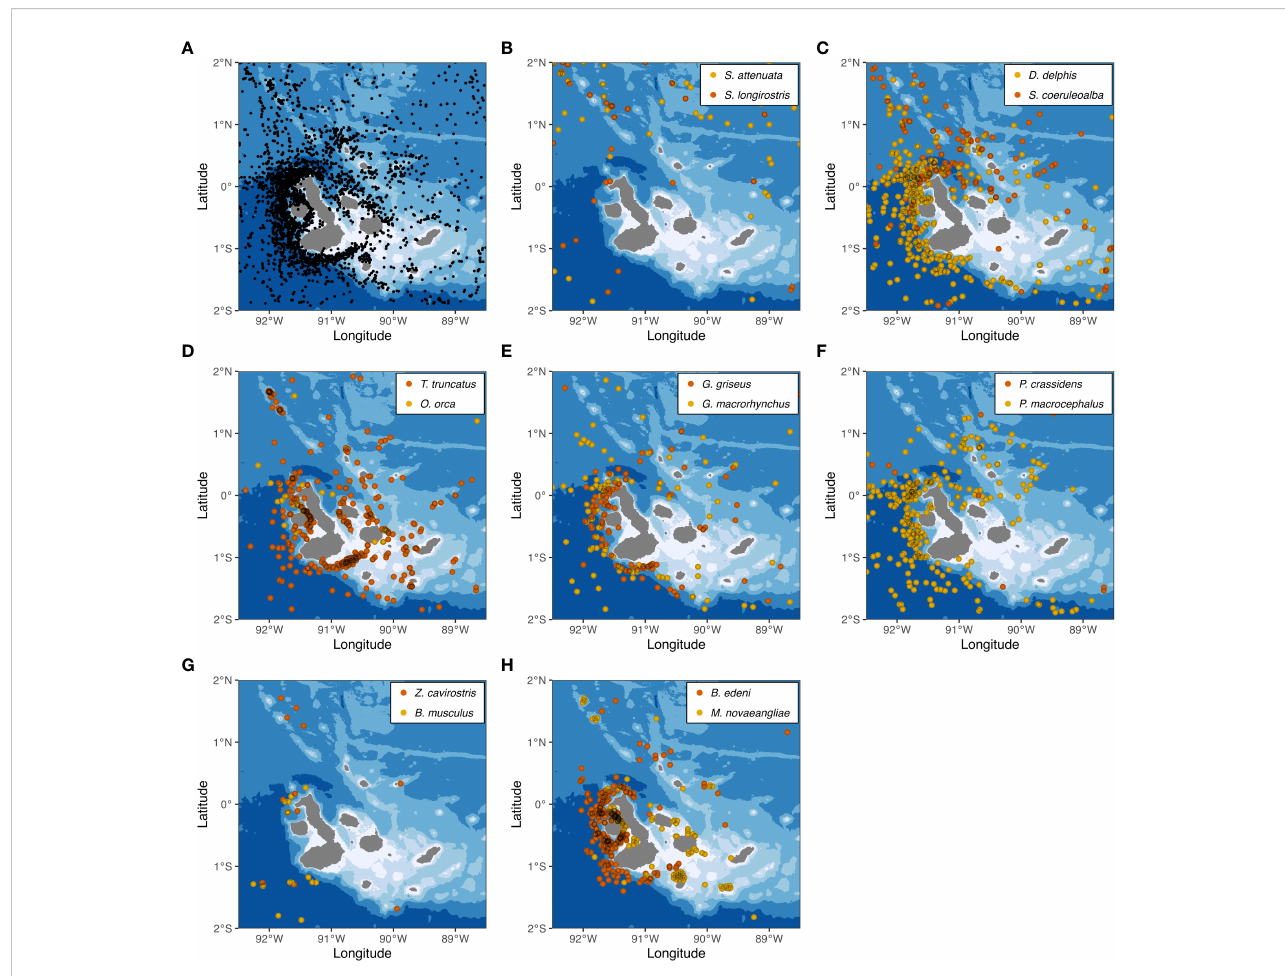
FIGURE 2 Maps depicting the distribution of 14 cetacean species commonly seen in Galápagos waters. (A) Locations of all marine mammal sightings (identi fi ed and unidenti fi ed) from a compilation of sightings (n = 3,227), used here as a proxy for search effort. (B) Sighting locations for S. attenuata (n = 75) and S. longirostris (n = 45). (C) Sighting locations for D. delphis delphis (n = 339) and S. coeruleoalba (n = 126). (D) Sighting locations for T. truncatus (n = 346) and O. orca (n = 29). (E) Sighting locations for G. griseus (n = 101) and G. macrorhynchus (n = 93). (F) Sighting locations for P. crassidens (n = 10) and P. macrocephalus (n = 260). (G) Sighting locations for Z. cavirostris (n = 11) and B. musculus (n = 17). (H) Sighting locations for B. edeni brydei (n = 291) and M. novaeangliae (n = 88). Marine mammal sighting data from Palacios (1999b), Palacios and Salazar (2002), Palacios (2003), Fe ́ lix et al., (2011), and Cantor et al., (2017), used with permission or under Creative Commons licenses CC BY and CC BY-NC. Bathymetry data from SRTM15+ (Tozer et al., 2019), available from